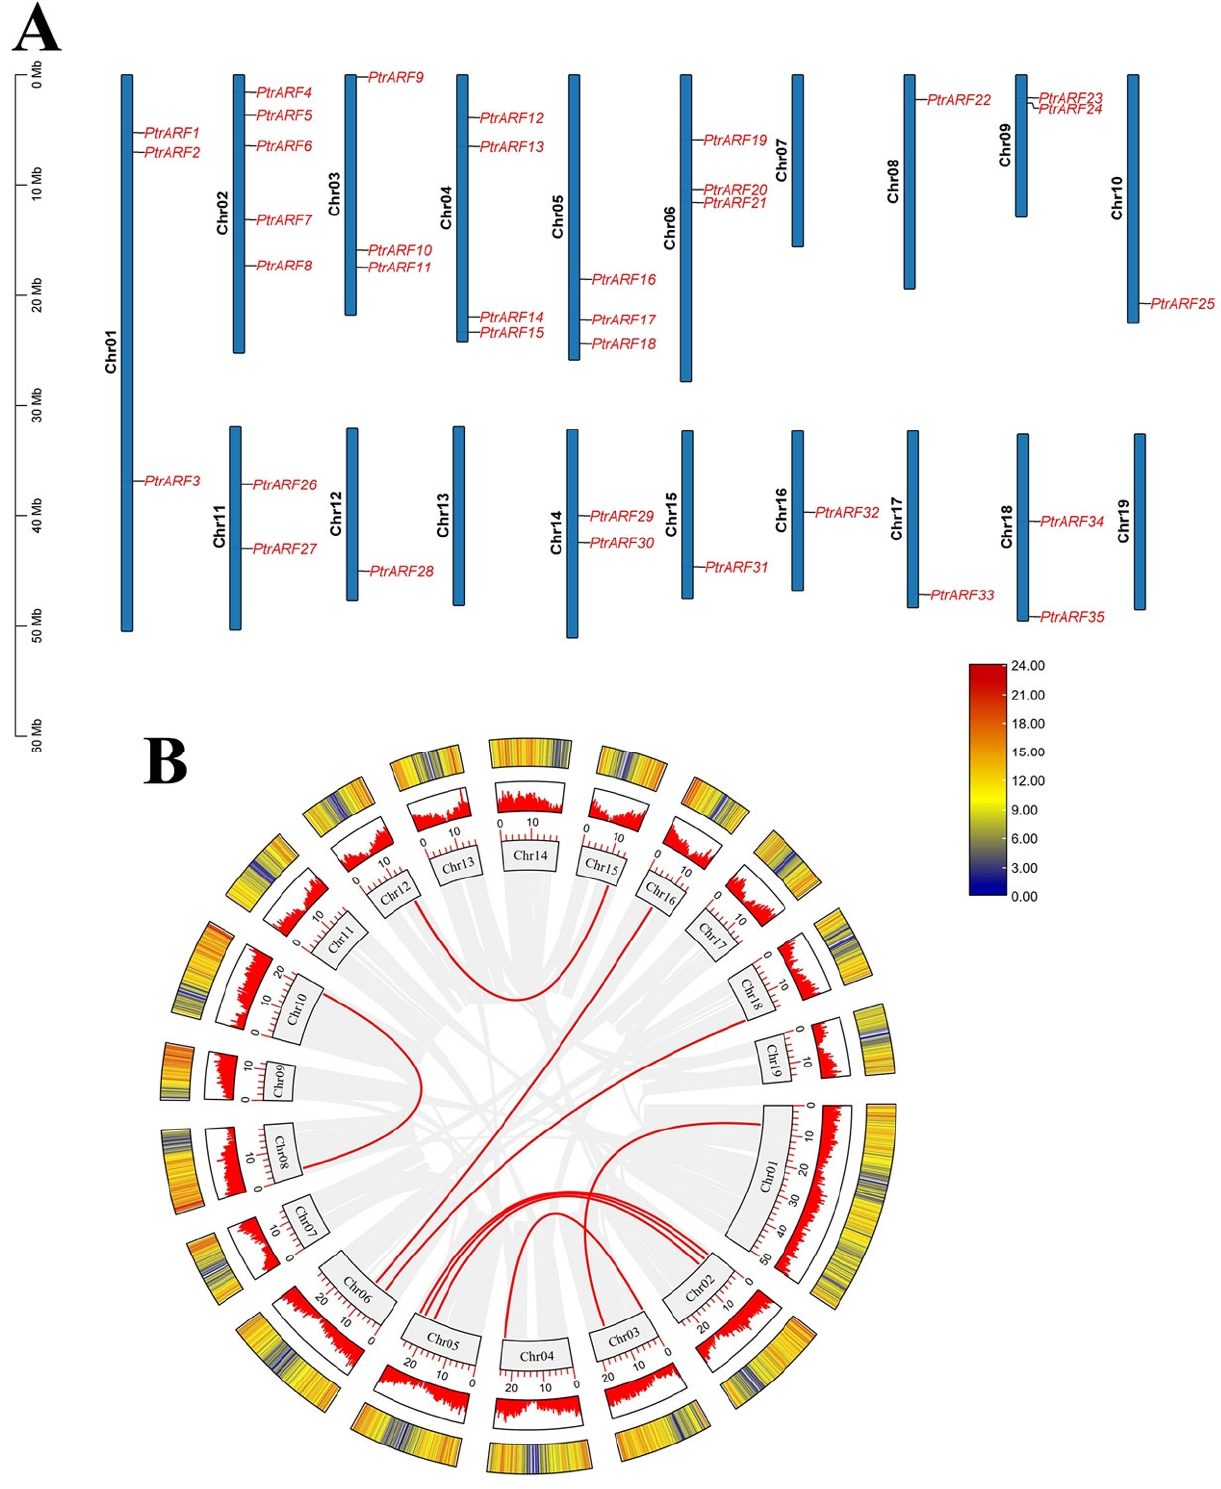
Figure 2. Chromosome distribution and synteny relationships of PtrARF gene family. ( A ) Chromosomal locations and duplicated gene pairs of distribution of 35 PtrARF genes. Each gene was mapped to the chromosome based on its physical location. The chromosome number (Chr01–Chr19) is indicated at the left; ( B ) circle map of the duplication gene pairs of the PtrARF genes. The heatmap and the histograms in rectangles represent the gene density on the chromosomes. The red lines represent collinear pairs of PtrARF genes, while the gray lines indicate collinear blocks of all poplar genes.